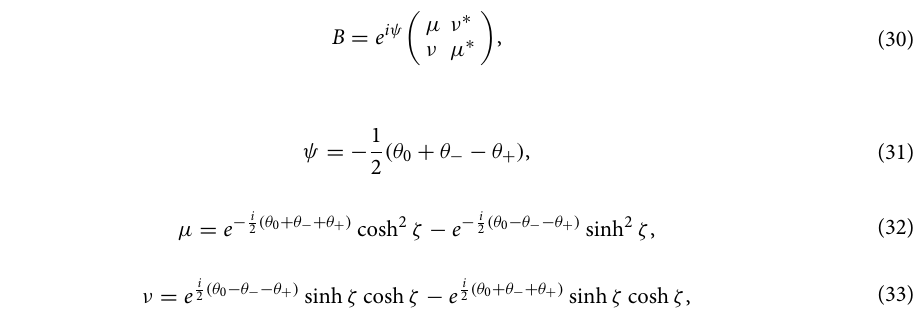
8 H 16 F 5000 , Ic 4 10 2.5 10 , C rh , γ − − = = × = × 6 m 10 − =